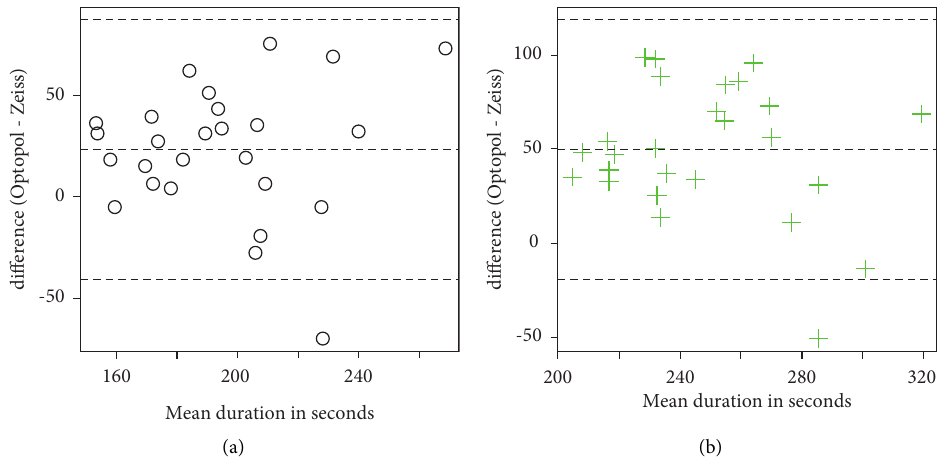
Figure 2: Bland–Altman plots for the time to complete the test (in seconds). For each subject, the mean of the measurement from the Zeiss and Optopol machines is taken and plotted on the x -axis. The y -axis is the difference between the Optopol and Zeiss measurements. The plot on (a) is for control subjects; the plot on (b) is for subjects with glaucoma.